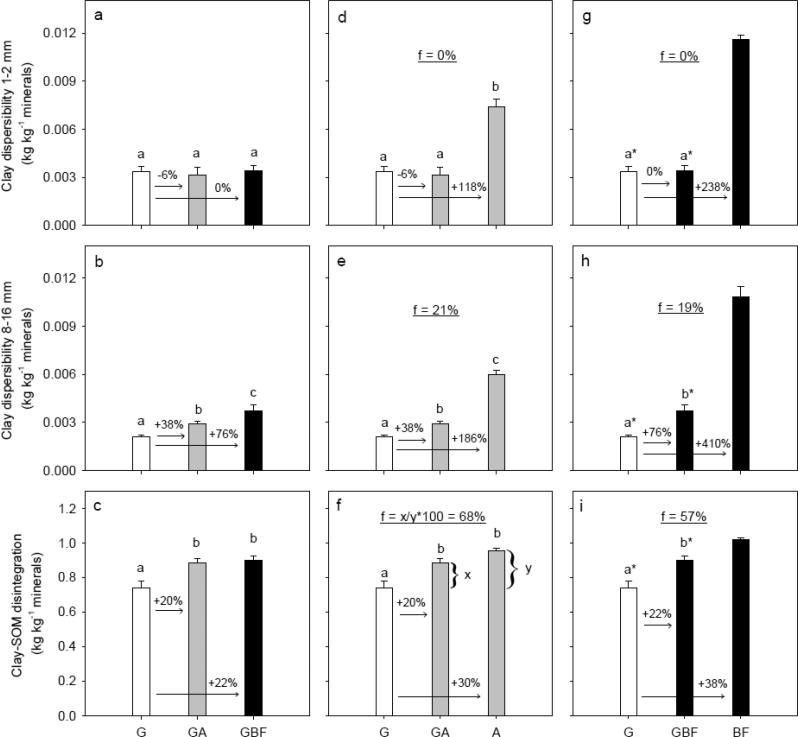
Degradation scenarios: Management system effects on clay dispersibility of 1–2 mm aggregates rewetted to −100 hPa, clay dispersibility of 8–16 mm aggregates rewetted to −100 hPa, and clay-SOM disintegration (the ratio between clay particles retrieved without SOM removal and with removal). White, gray and black bar fills highlight treatments grass, arable and bare fallow, respectively, at time of sampling. Letters denote statistical significance at P < 0.05. An asterisk (*) indicates if BF is significantly different from GBF and G based on a pairwise t-test. The numbers above the arrows denote relative differences. The underlined number in the middle part of the figures denotes the difference after six years in relation to the long-term difference, and an example of the calculation is shown in Fig. f. For treatment abbreviations, see Fig. 1.